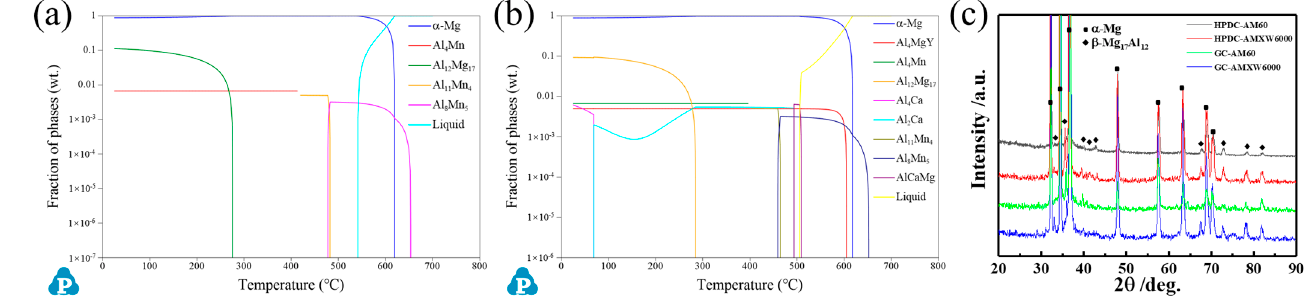
Figure 1. Solidification calculation of ( a ) AM60 alloy and ( b ) AMXW6000 alloy by Pandat TM ; ( c ) XRD patterns of AM60 and AMXW6000 alloys under GC and HPDC.